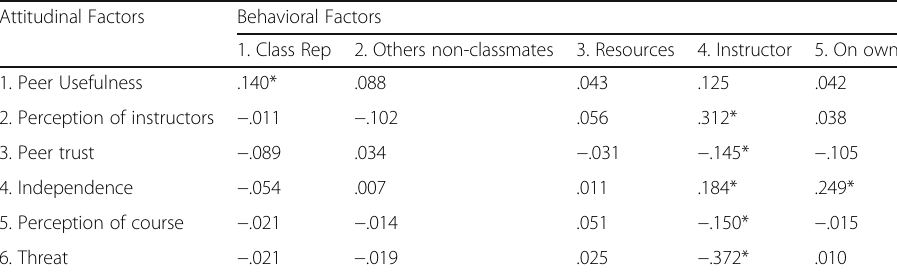
Table 4 Correlation of attitudinal and behavioral factors Attitudinal Factors Behavioral